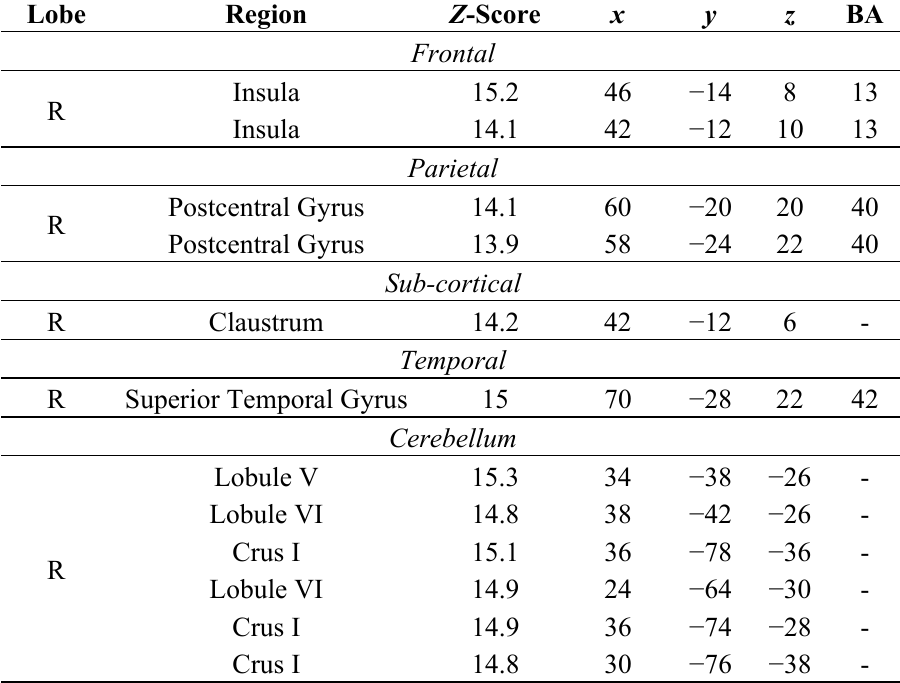
Table 5. Stereotactic MNI coordinates, Z -score values, and anatomical and Brodmann areas for activations during the Melody condition contrasted to